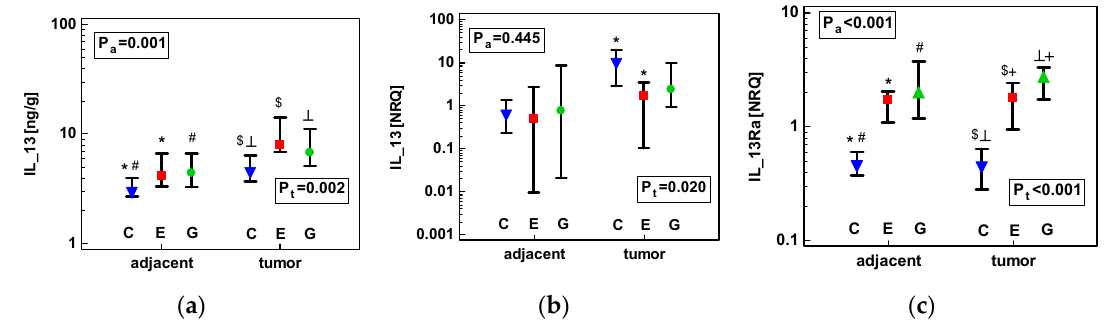
Figure 8. Effect of anatomical site on tumor and tumor-adjacent tissue expression of: ( a ) IL-13 protein; ( b ) IL13 mRNA; ( c ) IL13Ra1 mRNA. Data analyzed as logs using one-way ANOVA and presented as geometric means with 95% confidence interval (whiskers). Blue triangles represent mean values in colorectal cancers (denoted as C); red squares represent mean values in esophageal squamous cell carcinoma (denoted as E); green circles represent mean values in gastric adenocarcinoma (denoted as G). p values for the analysis in adjacent tissue are denoted as P a and for tumor tissue as P t . Statistically significant differences between groups are marked with symbols of the same type (*, #, etc.). Transcriptomic data presented as normalized relative quantities (NRQ).